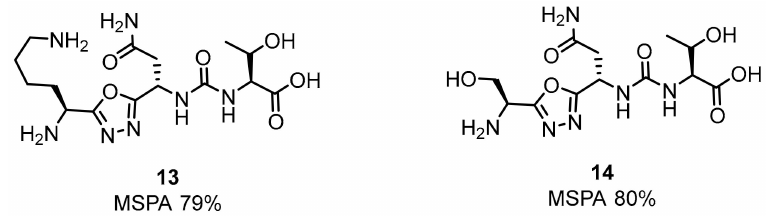
Figure 8. Examples of Aurigene’s small-molecule